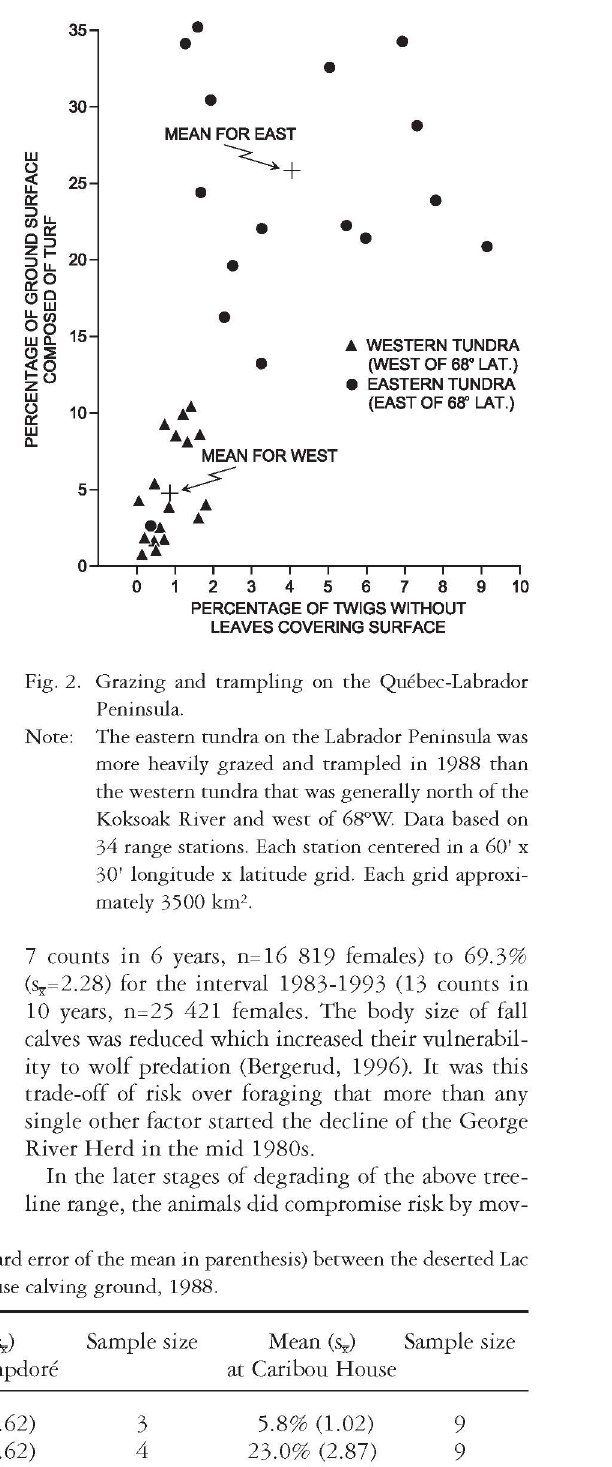
Table 2. Comparison of the range destruction in % (standard error of the mean in parenthesis) between the deserted Lac Champdore calving ground and the Caribou House calving ground, 1988. Weather